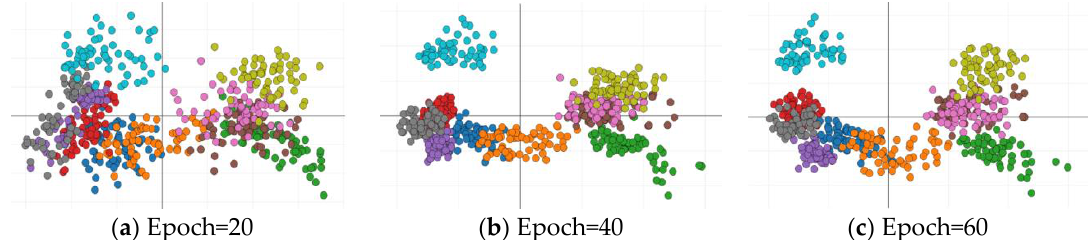
Figure 6. The distribution of feature points from the multi-classifier of MCGAN in different epochs (64 × 64 input): ( a ) Epoch = 20, ( b ) Epoch = 40, and ( c ) Epoch = 60. Different colors represent different categories. With increasing the training epoch, the diverse classes of feature points are gradually separated, indicating the low level layers of the discriminator having learnt the category information from the labeled samples during the training of MCGAN.